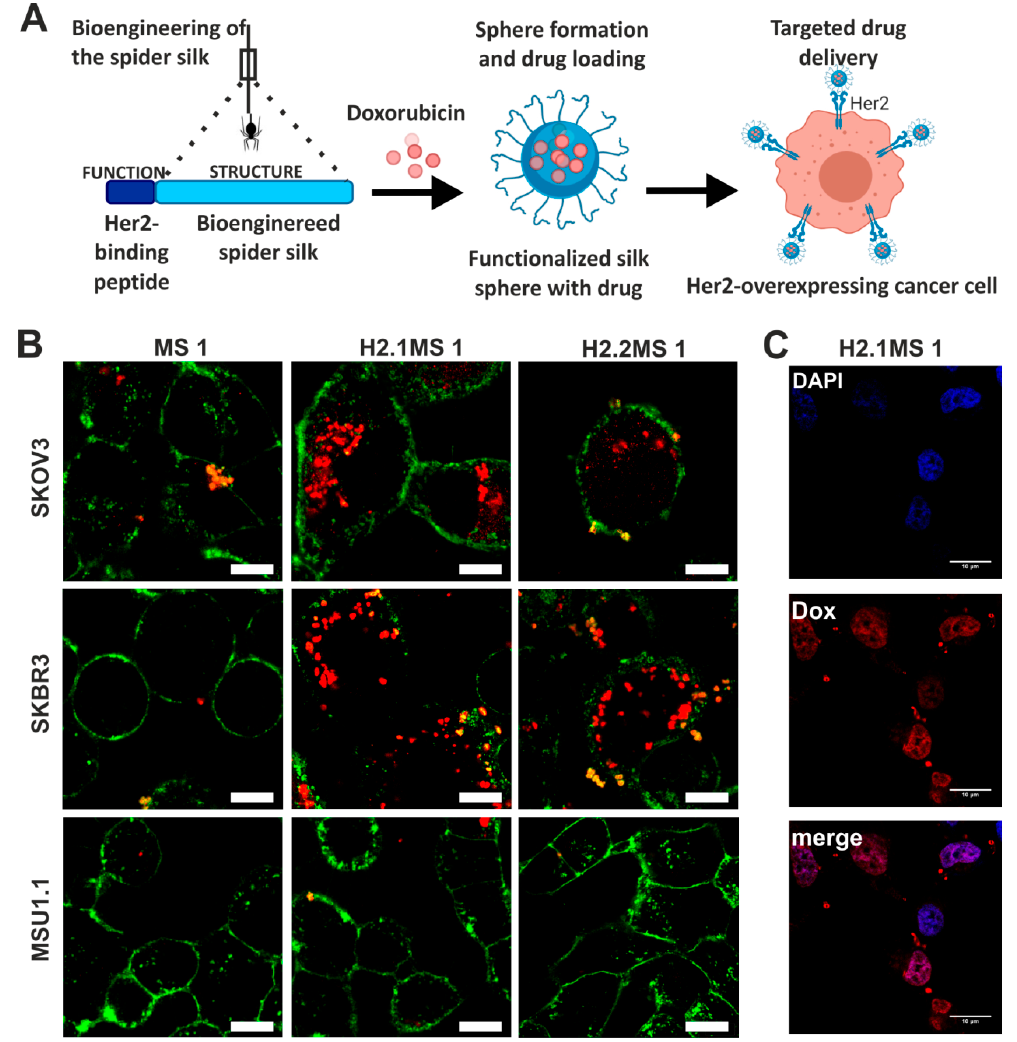
Figure 4. Functionalized spider silk nanospheres as drug carriers for targeted therapy of Her2-overexpressing tumors. ( A ) Schematic representation of DDS based on bioengineered spider silk that targets specifically Her2-overexpressing cancer cells. ( B ) Fluorescently labeled spheres that were functionalized with Her2-binding peptide H2.1 and H2.2 (H2.1MS1 and H2.2MS1) were effectively internalized into the cytoplasm of Her2(+) cells (SKOV-3 and SKBR-3) in contrast to non-functionalized spheres (MS1) and control Her2( − ) (MSU1.1) cells. Cell membrane stained with ConA-FITC (green) and particles conjugated with ATTO 647N (red). Scale bar: 10 μ m. ( C ) Dox was released from the H2.1MS1 spheres inside SKBR3 cells, and the colocalization of signals derived from Dox and the nucleus was observed. The nuclei stained with DAPI (blue) and autofluorescence of Dox (red). Scale bar: 10 μ m. Reproduced with permission [71]. Copyright, 2014, American Chemical Society.